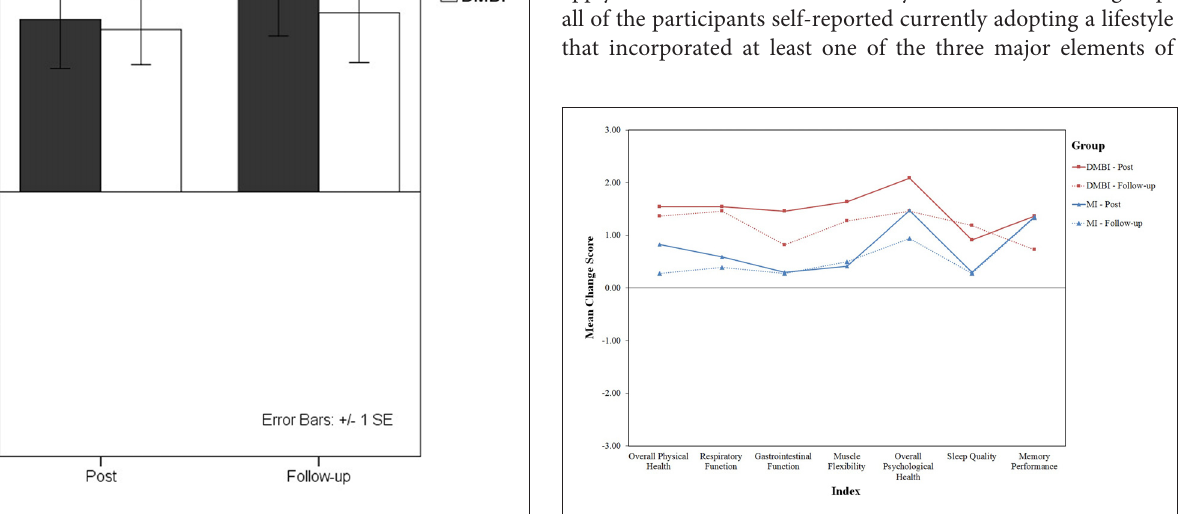
FIGURE 2 | Mean score of six indices indicating changes in subjective physical and psychological health (i.e., Overall Physical Health, Respiratory Function, Gastrointestinal Function, Muscle Flexibility, Overall Psychological Health and Sleep Quality) in the DMBI ( n = 11; red) and MI ( n = 18; blue) groups at post-assessment (solid lines) and at follow-up assessment (dotted lines). One participant in the MI group was excluded at post-assessment because of missing